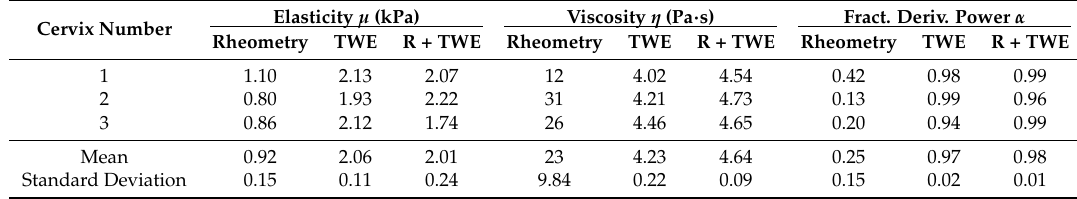
Table 3. Viscoelastic parameters using the data from rheometry, TWE, and a combination of the two methods for the Kelvin–Voigt Fractional Derivative